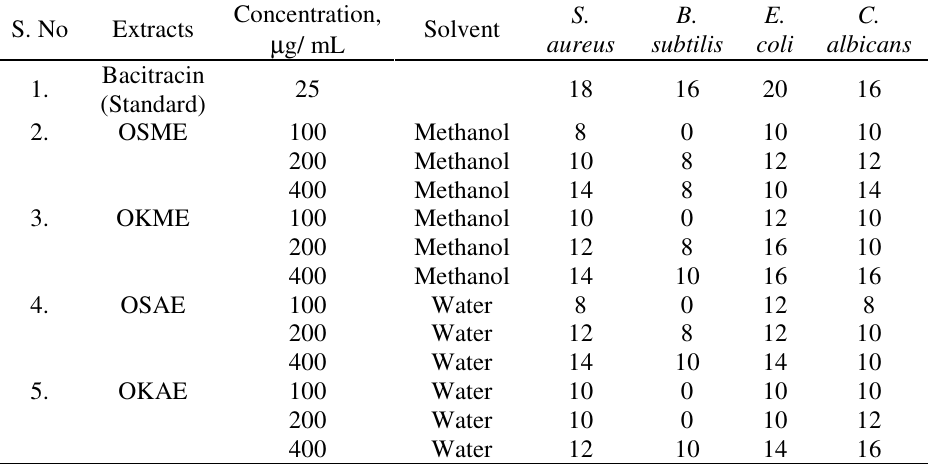
Table 1 . Zone of inhibition (in mm) of different organisms and the different concentration of extracts used Concentration, S. No Extracts µ g/